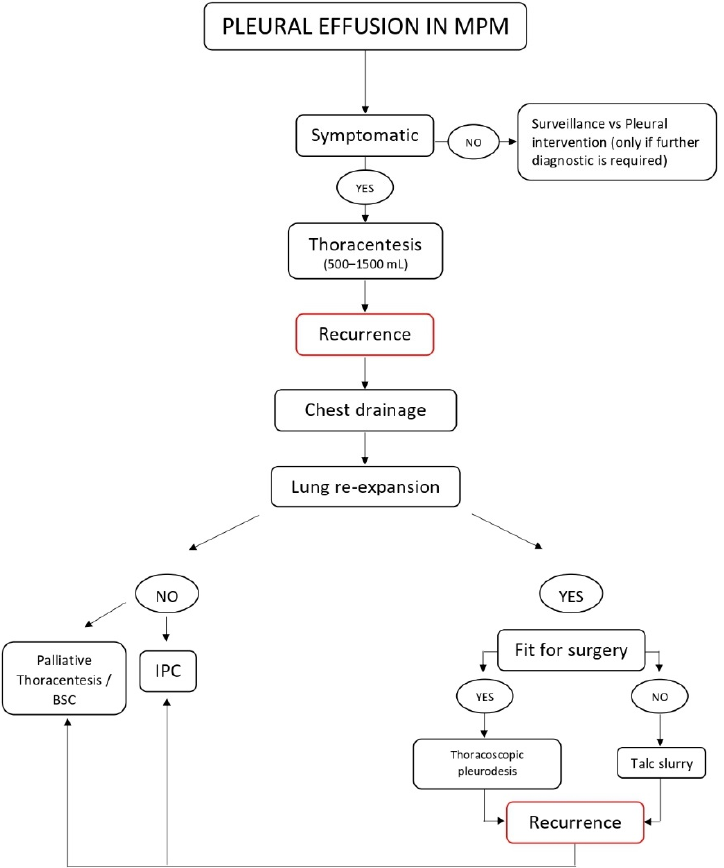
Figure 1. Management of pleural effusion in